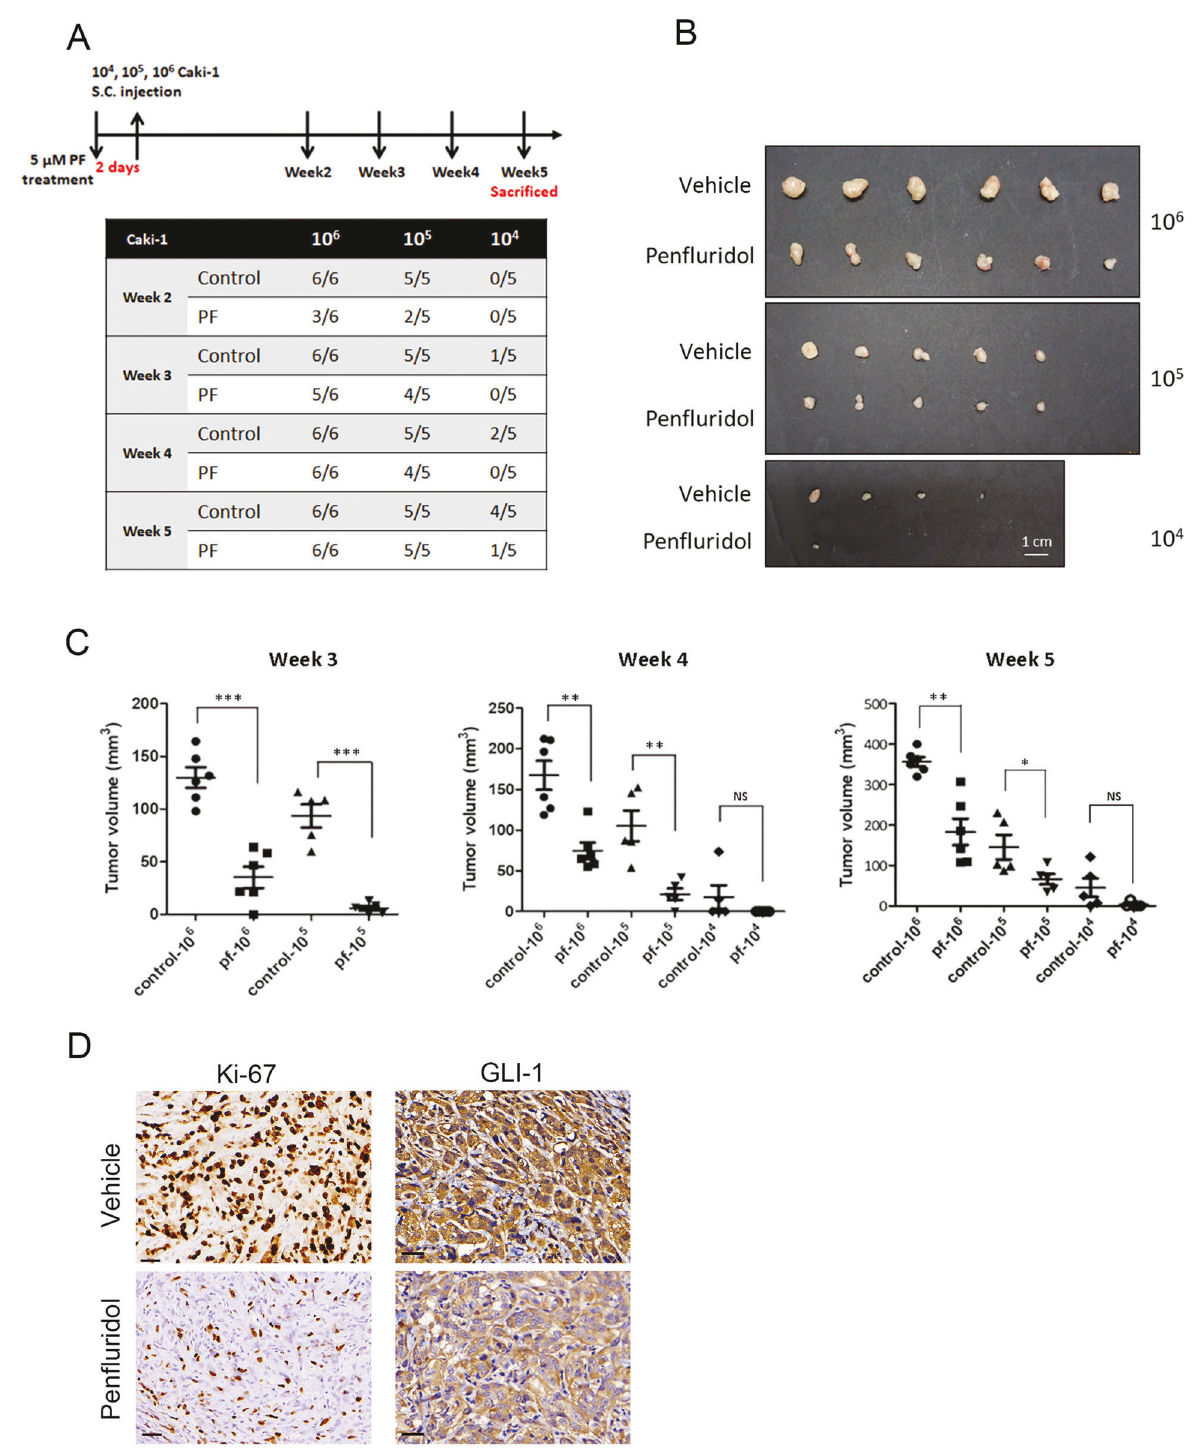
Fig. 6 Tumorigenicity in vivo xenograft and limiting dilution assay. A Upper panel, timeline of the in vivo study design for investigating the antitumor activity of pen fl uridol. Caki-1 clear cell renal cell carcinoma (ccRCC) cells that had been treated with pen fl uridol (5 µM) or the vehicle. For the limiting dilution analyses, the indicated numbers of cells were subcutaneously injected into male NOD-scid IL2R γ null (NSG) mice ( n = 5 or 6 per group). Two weeks after tumor cell injection, the tumor volume in mice was checked every week. Lower panel, numbers of tumors generated and results of the limiting dilution assay. Numbers of tumors generated by the cell lines were recorded every week and are shown in the table. B All mice were sacri fi ced at 5 weeks after tumor cell injection, and tumors were dissected and photographed. C Tumor development from vehicle- and pen fl uridol-treated groups. Tumor volumes were recorded at the 3rd, 4th, and 5th weeks after tumor cell injection and are reported as the mean ± standard error of the mean (SEM). * p < 0.05, ** p < 0.01, and *** p < 0.001 compared to the vehicle group. NS, not signi fi cant. D Caki-1 xenografts treated with vehicle or pen fl uridol were isolated to detect expressions of Ki67 and GLI1 by IHC staining. Original magni fi cation, 400x. Scale bar, 30 μ m.